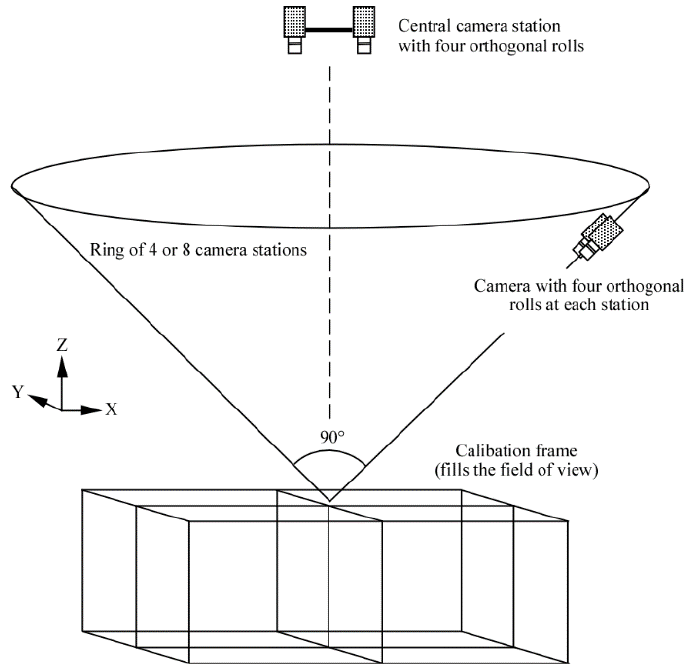
Figure 1. Typical portable calibration fixture (( Left ), courtesy of NOAA) and test range (( Right ), from [25]).